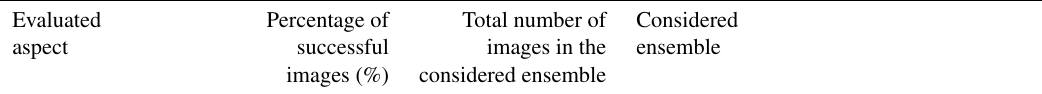
Table 4. Eye evaluation of the performance of the ELIFAN algorithm: percentage of successful processed images in various situations or aspects over the entire year. The total number of images of the considered ensemble is specified in each